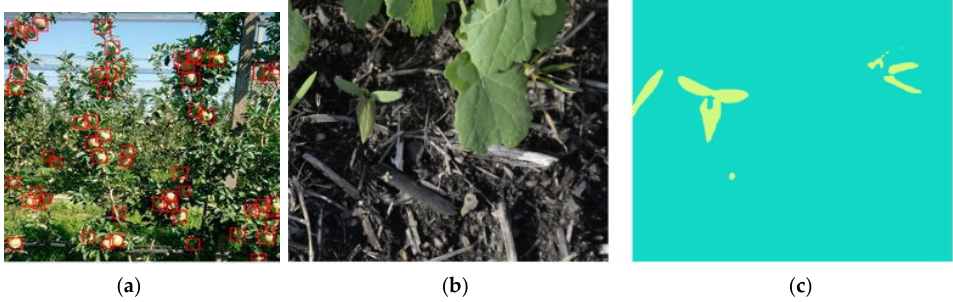
Figure 7. Detection of objects within dense scenes: ( a ) for apples [99], ( b ) canola and weeds (initial image) [100], ( c ) weeds after semantic segmentation [100].